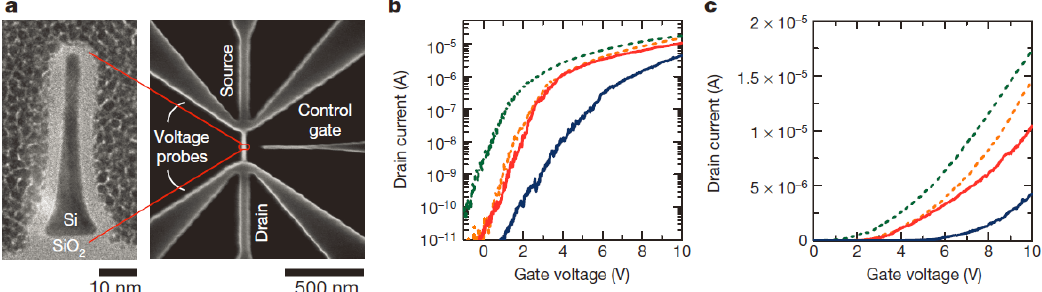
Figure 12. Image of the nanowire flash memory device and the drain current behavior with an applied voltage to the control gate. ( a ) Cross-sectional image (left) of the memory device and the top view (right) of a device with a 5-nm Si nanowire channel and side control gate; measurements of the logarithmic ( b ) and linear ( c ) drain current versus gate voltage at 0.5 V source-drain voltage: before deposition of the polyoxometalates (POMs) (green dashes), after the deposition of the POMs (orange dashes), after a − 20 V pulse (blue line) and after a 120 V pulse (red line). Reproduced with permission from [56], © American Chemical Society, 2014.